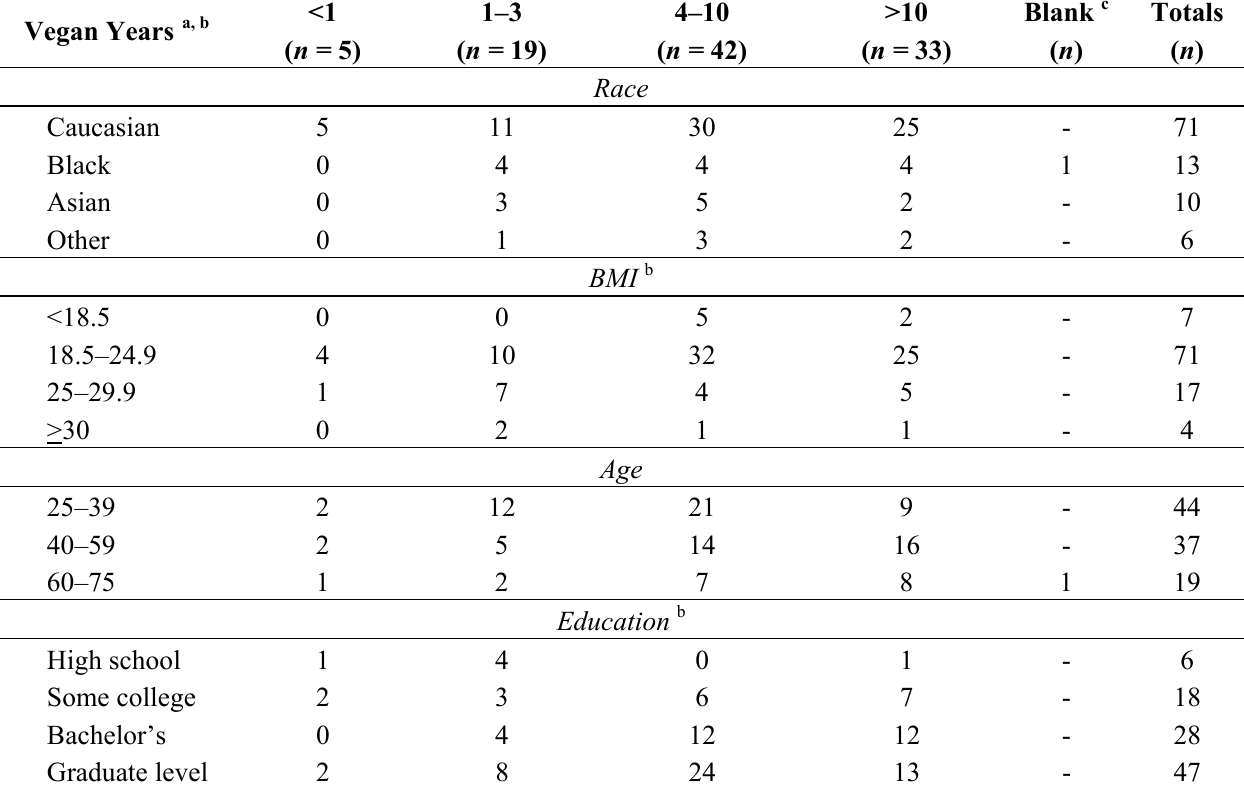
Table 1. Demographic data for vegan study